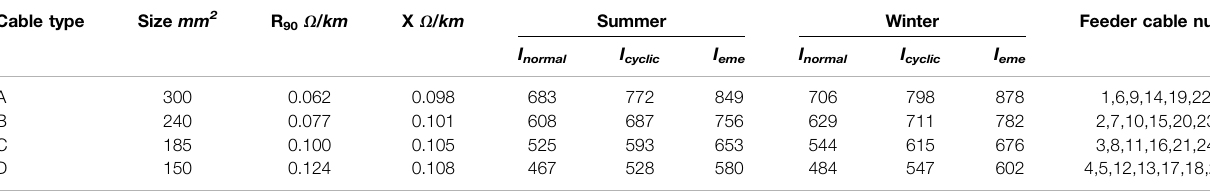
TABLE 2 | The cable electrical properties modeled in the RBTS bus four network.